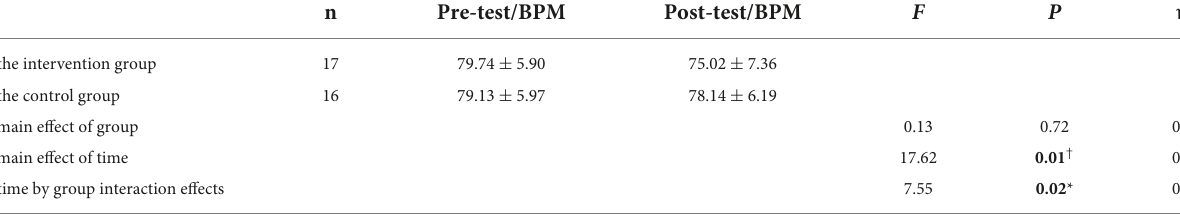
TABLE 3 Results of the analysis of HR in the two groups of patients in the pre-test and post-test.